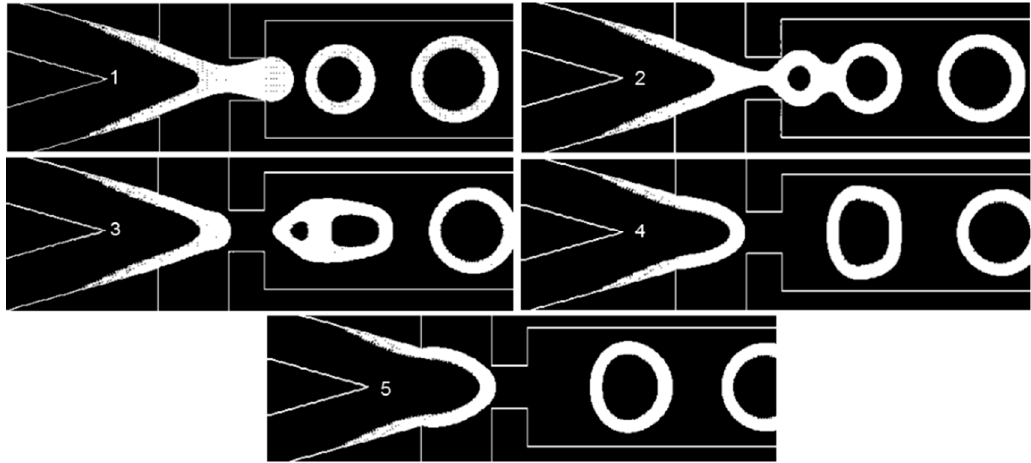
Figure 7. Here, θ wall = 5°, σ = 0.06 N/m, and EF = 2.63. The pictures numbered 1 to 5 show the W/O common interface at di ff erent time instants in the injection tip (Video common interface at different time instants in the injection tip (Video S1).